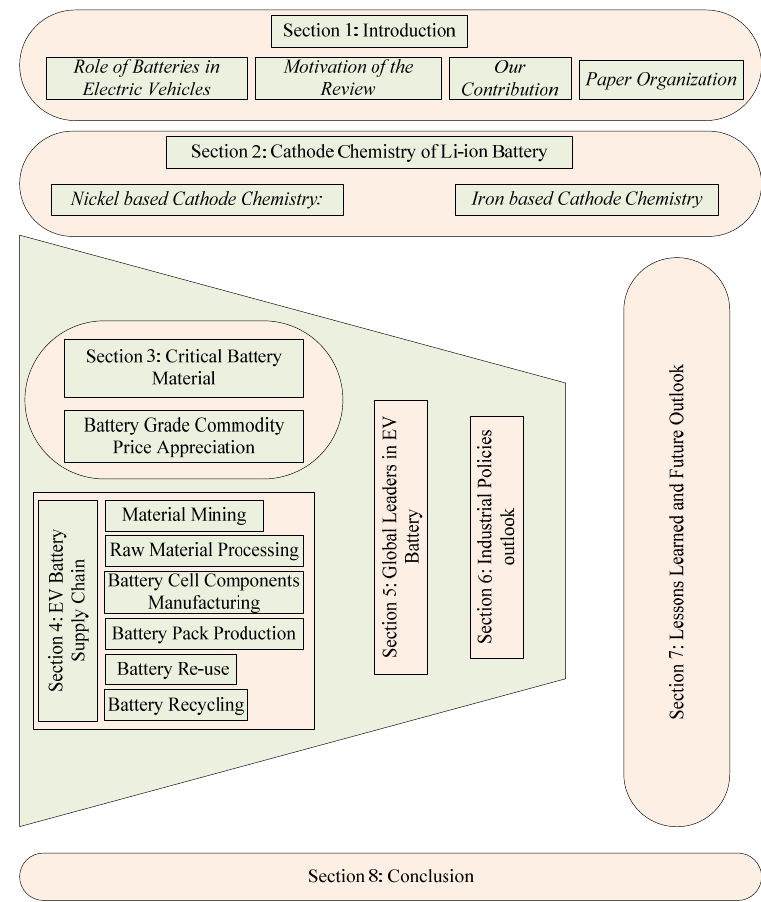
Figure 3. Organization of the